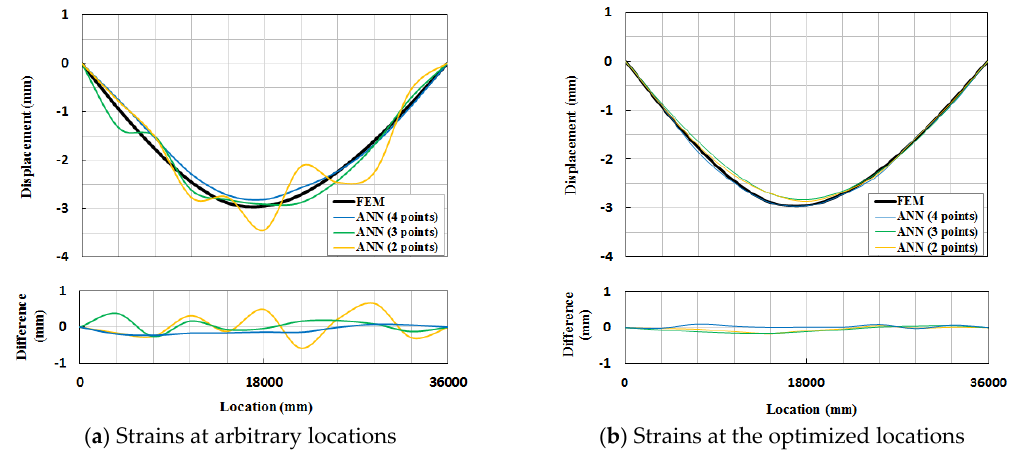
Figure 18. Overall displacements shape at t = 2.59 s (max. displacement) for the 80 km/h test dataset. Table 7. The results of the ANN test for three test datasets.